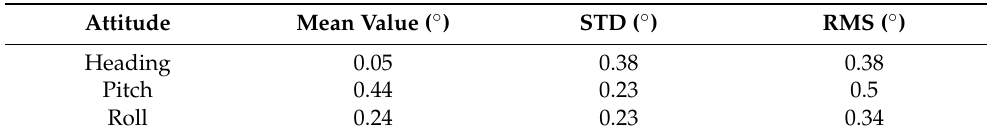
Table 6. Results of the comparison tests under standing conditions expressed in terms of the differ- ences between the measured and reference angles.